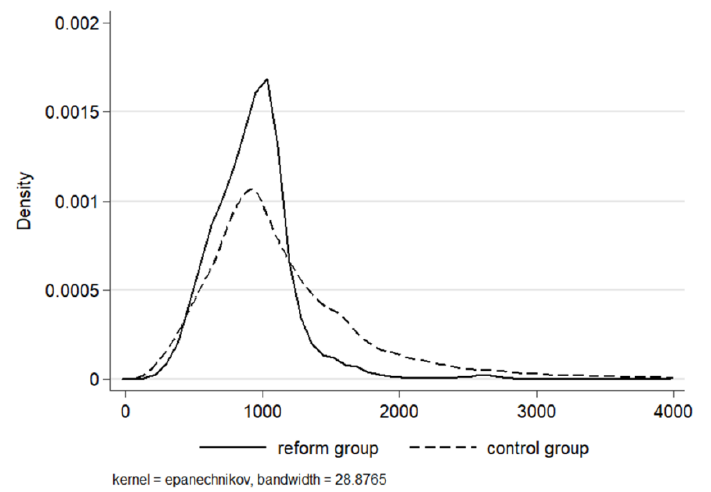
Figure 3. Distribution of the medical costs in the control and reform groups. To clearly display the density, a 95% winsorization of the high ends was processed. density, a 95% winsorization of the high ends was processed. Table 3. Quantile difference-in-differences estimates of medical